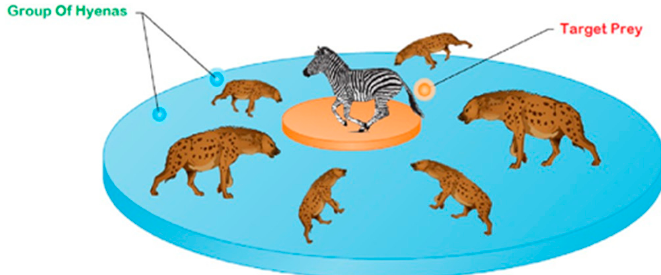
Figure 5. Searching for prey (| E | > 1).